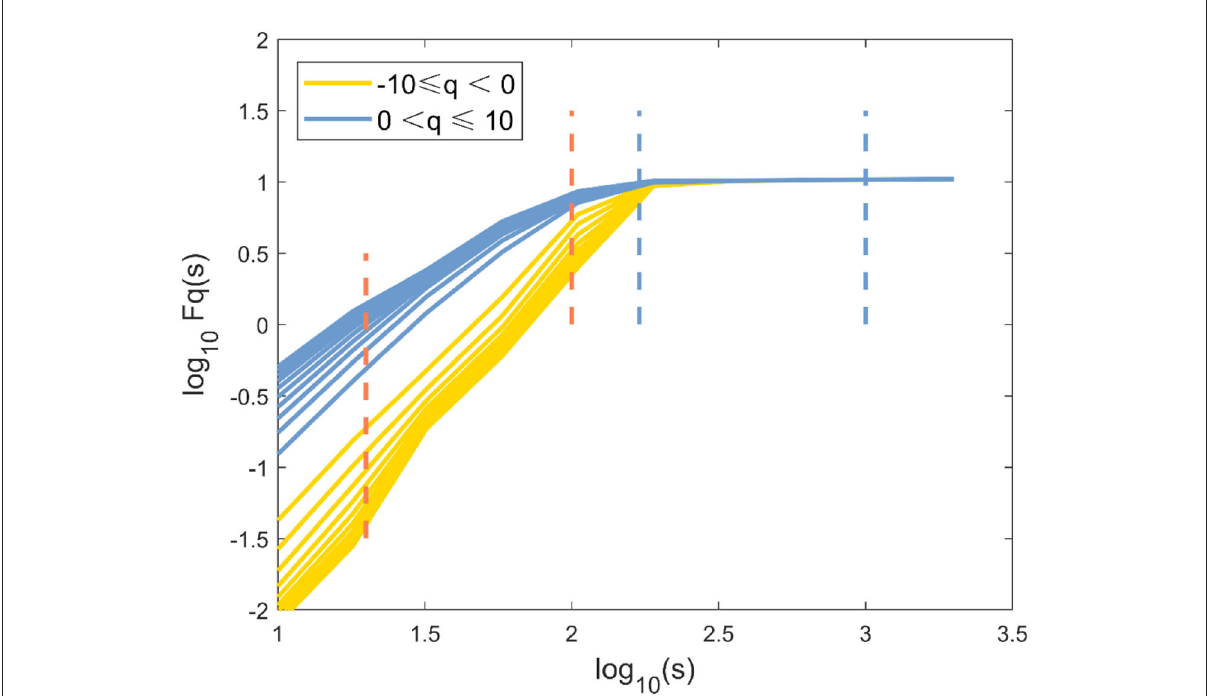
FIGURE2 The fluctuation function logF q ( s ) vs. log10( s ) with − 10 ≤ q ≤ 10 and its behavior over a range of s for knee angle time series of one healthy subject by